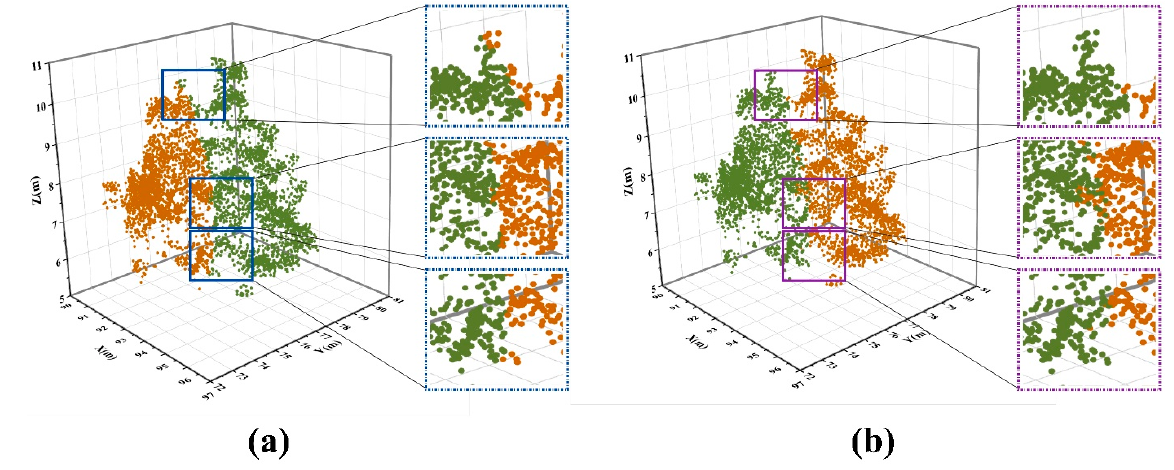
Figure 8. ( a ) After the first clustering segmentation, there is an obvious over division of the canopy on the right; ( b ) the re-clustering segmentation after adding the compensation term makes the two canopies more reasonably